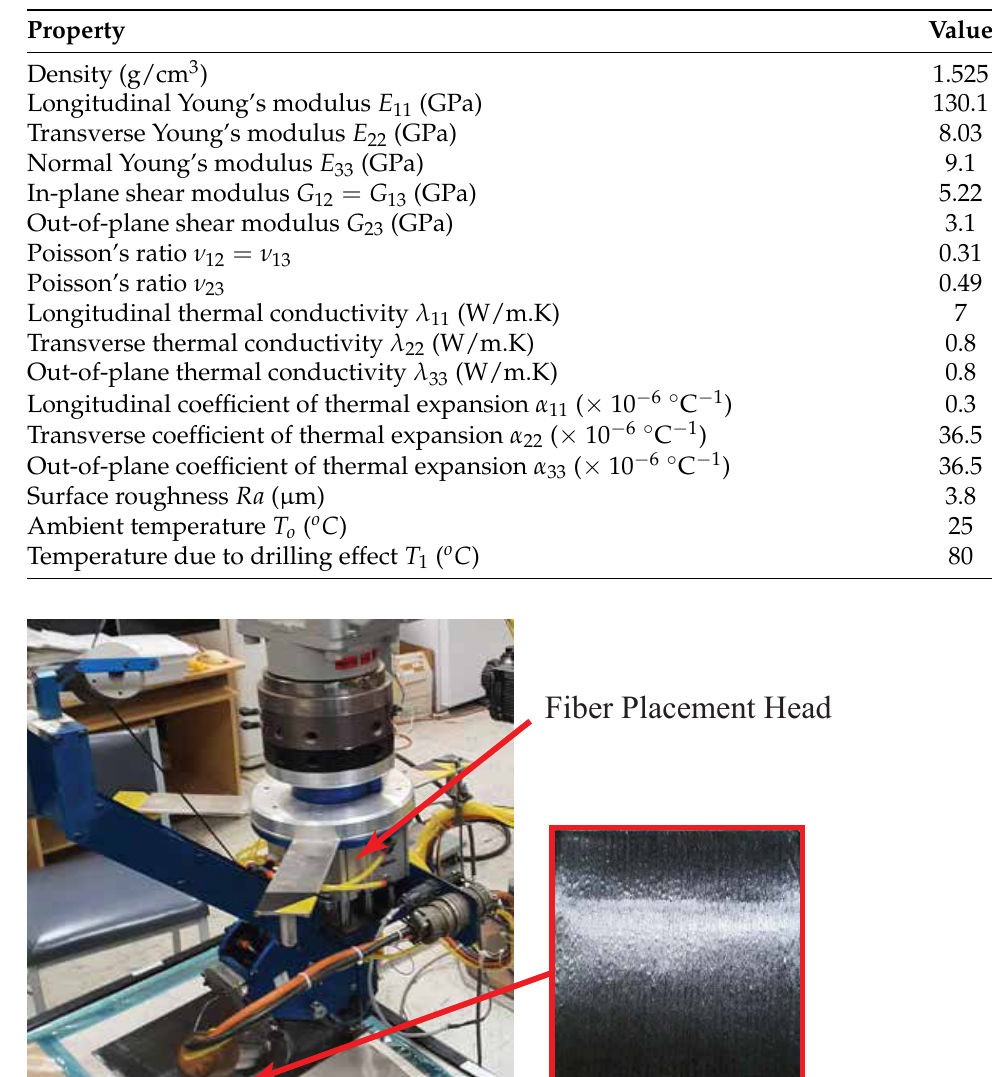
Table 2. CFRP (T700/2500) mechanical properties [36,37].